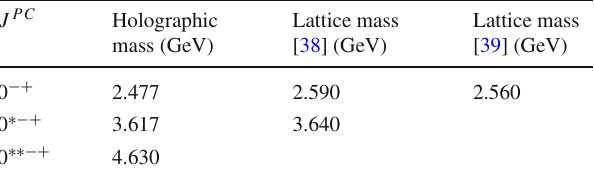
Table 1 Our holographic results for Glueball masses at zero tempera- ture, with k = 0.43 GeV, compared with lattice data [38,39] J